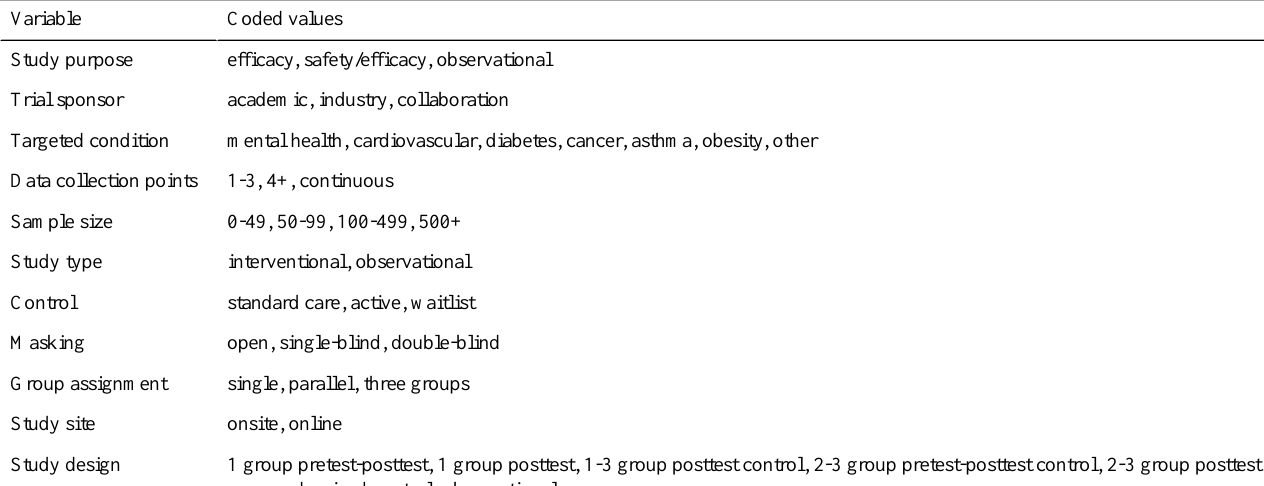
Table 1. Manually coded study variables from extracted ClinicalTrials.gov registry data. Coded